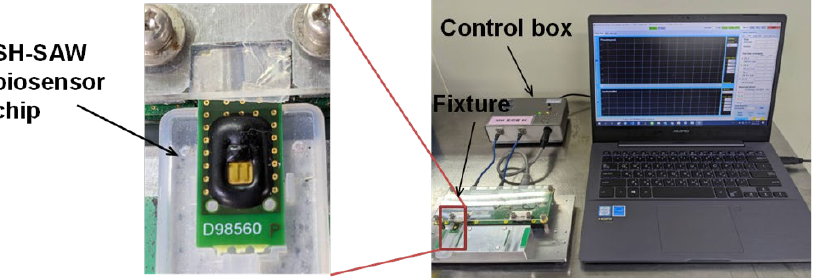
Figure 2. SH-SAW biosensor chip and measurement system. The left panel is an enlarged view of the measurement device in the system. The control box is connected to a fixture to which two SH-SAW biosensor chips can be connected.